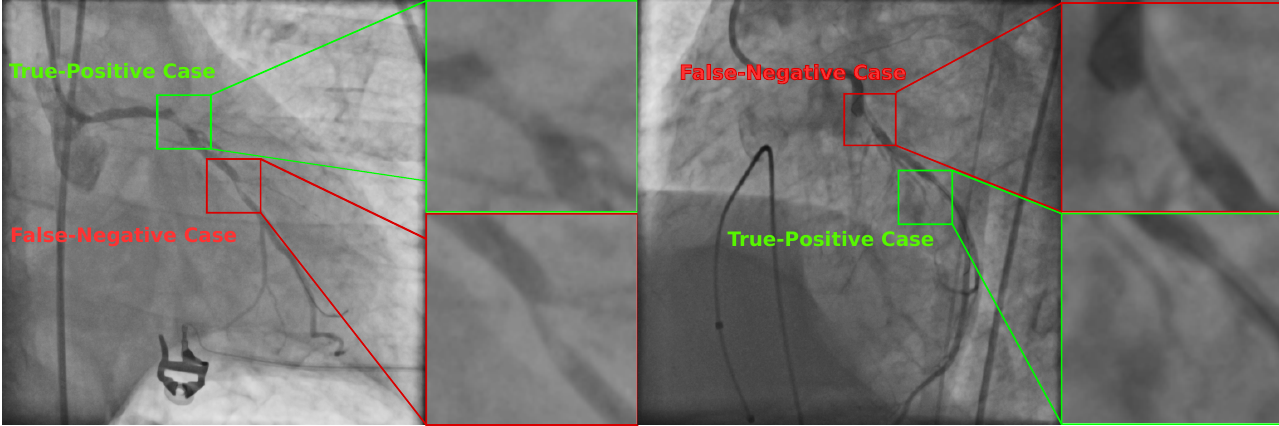
Figure 6. Selected X-ray angiograms with True-Positive and False-Negative stenosis cases detected by the SVM-based classifier using the set with 20 features found by